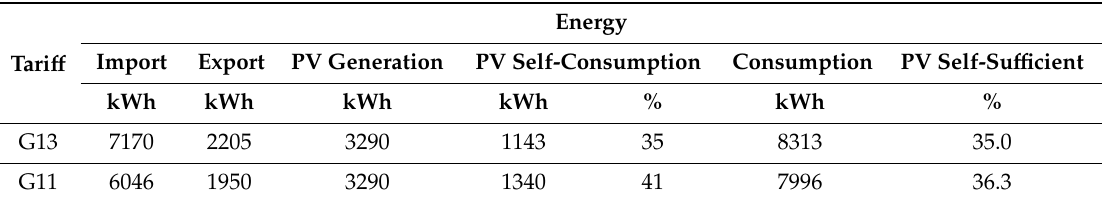
Table 12. Recalculation of energy consumption from tari ff G13 to tari ff G11 in 2019.